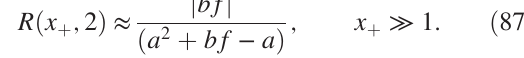
; x − Þ (solid curves) and R 1 ð x FIG. 6. Relative errors R ð x þ ; x − Þ is computed using Eq. (76), (dashed curves) versus ε . R ð x þ ; x − Þ is computed by a modified version of Eq. (76) while R 1 ð x þ where the skeleton-diagram contribution (38) is replaced by its first nontrivial order in ε . The gate used for the numerical experiments is gate 2 from Table I for x ∈ Z and density of defects δ ¼ 1